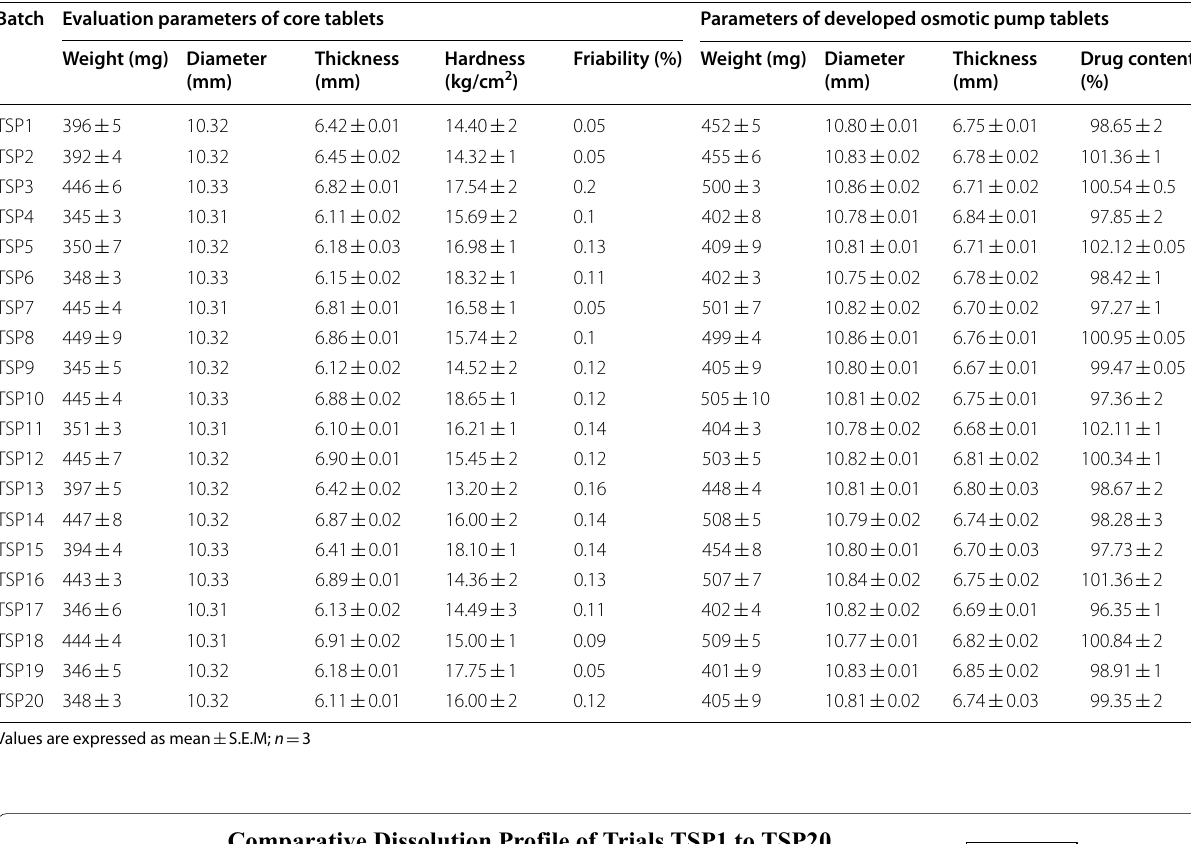
Table 8 Evaluation parameters of core and push–pull osmotic pump (PPOP) tablets of trospium chloride Batch Evaluation parameters of core tablets Parameters of developed osmotic pump tablets Weight (mg) Diameter (mm)